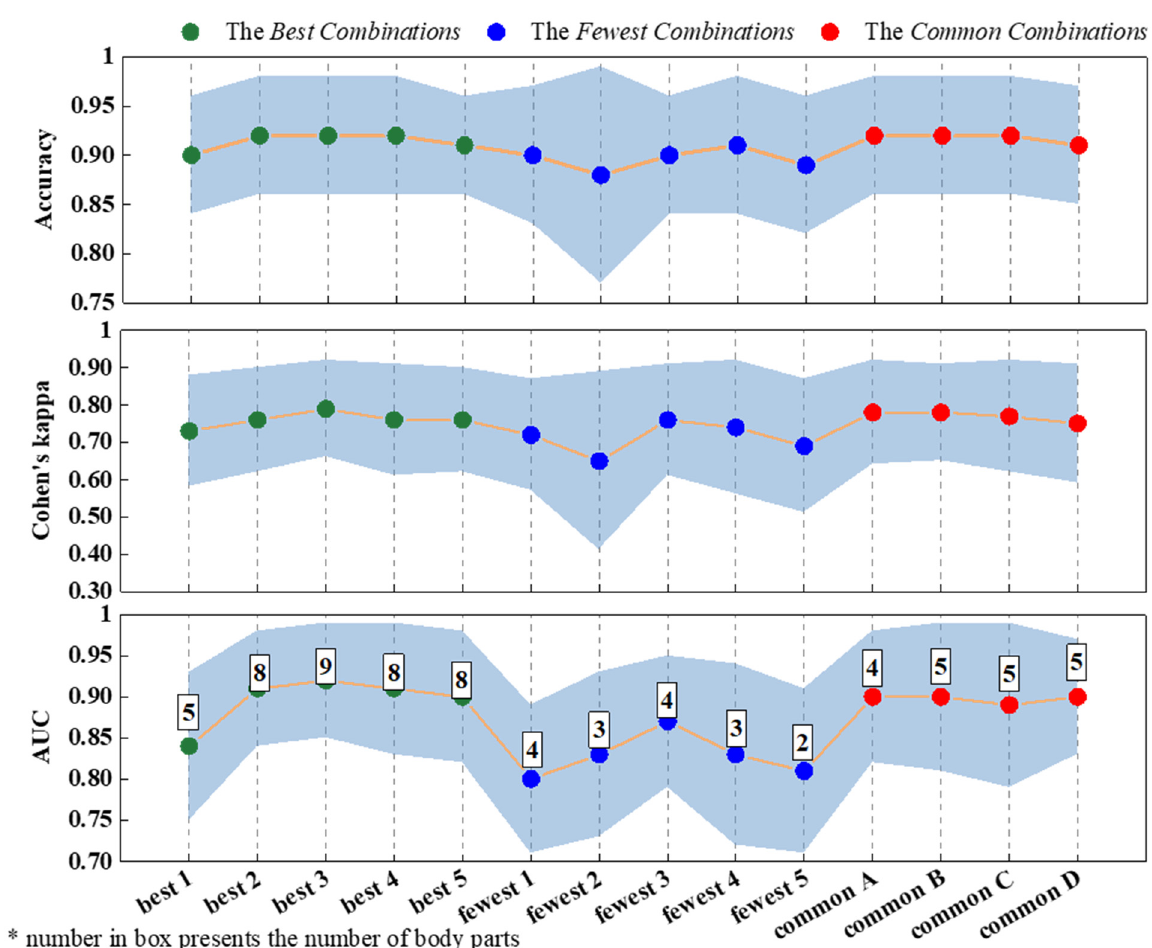
Figure 12. The average prediction power of all three combination types across the 14 subjects.